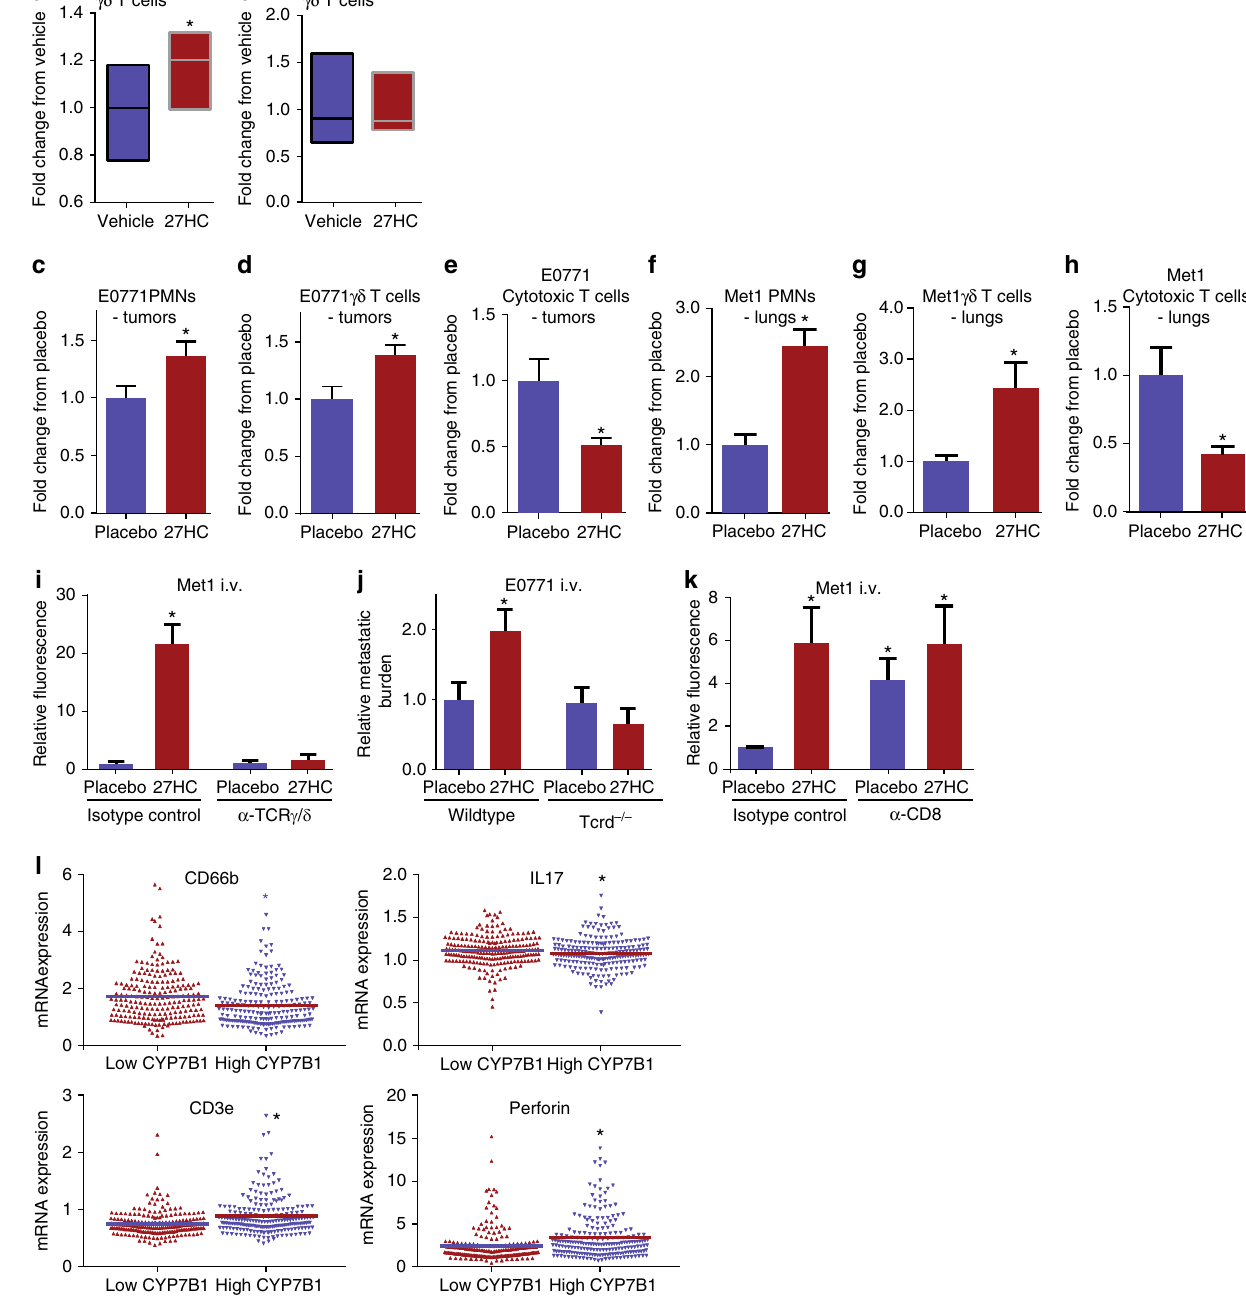
Fig. 4 27HC increases presence of γδ -T cells and PMNs, and decreases presence of cytotoxic CD8+ T cells within tumors and metastatic lungs. a Bone marrow-derived neutrophils were co-cultured with splenocytes in the presence or absence of 27HC for 4 days. At this time, cells were analyzed by fl ow cytometry for the presence of γδ -T cells ( N = 5/group). b The 27HC stimulated increase in γδ -T cells is not apparent when only splenocytes were cultured. c – e Early-stage E0771 tumors from mice treated with placebo or 27HC were analyzed by fl ow cytometry for γδ -T cells, PMNs and cytotoxic T cells (placebo N = 10, 27HC N = 9). f – h Early-stage metastatic lungs (Met1) from mice treated with placebo or 27HC were analyzed by fl ow cytometry ( N = 8/group). i γδ -T cells are required for the colonizing effects of 27HC, as immune-depletion of γδ -T cells with an antibody against TCR γδ ( α -TCR γ / δ ) ablates its effects on Met1 colonization of the lungs ( N = 8 except for isotype control 27HC group where N = 10). Mice were pretreated with indicated ligands for 5 days prior to engraftment with Met1 cells expressing iRFP (as in Fig. 2a). j γδ -T cells are required for the colonizing effects of 27HC, as 27HC fails to increase colonization in Tcrd − / − mice (from left to right N = 13, 12, 12, 13). k Immune depletion of CD8 + cells ( α -CD8) increases colonization, and exogenous 27HC treatment does not further increase colonization of Met1 cells to the lungs (from left to right : N = 9, 7, 8, 8). l Scatterplot analysis of TCGA data of 421 invasive breast cancer tumors for mRNA expression of CD66b, IL-17, CD3e, and PRF1 (perforin), parsed by median expression of CYP7B1. Results are depicted as mean +/ − SEM, with the exception of a , b , and l where the horizontal line depicts the mean. Asterisks denote statistical differences between groups ( p < 0.05). [ a – h : Unpaired two-tailed student ’ s t -test. i – k : One-way ANOVA followed by a Student Newman-Keuls